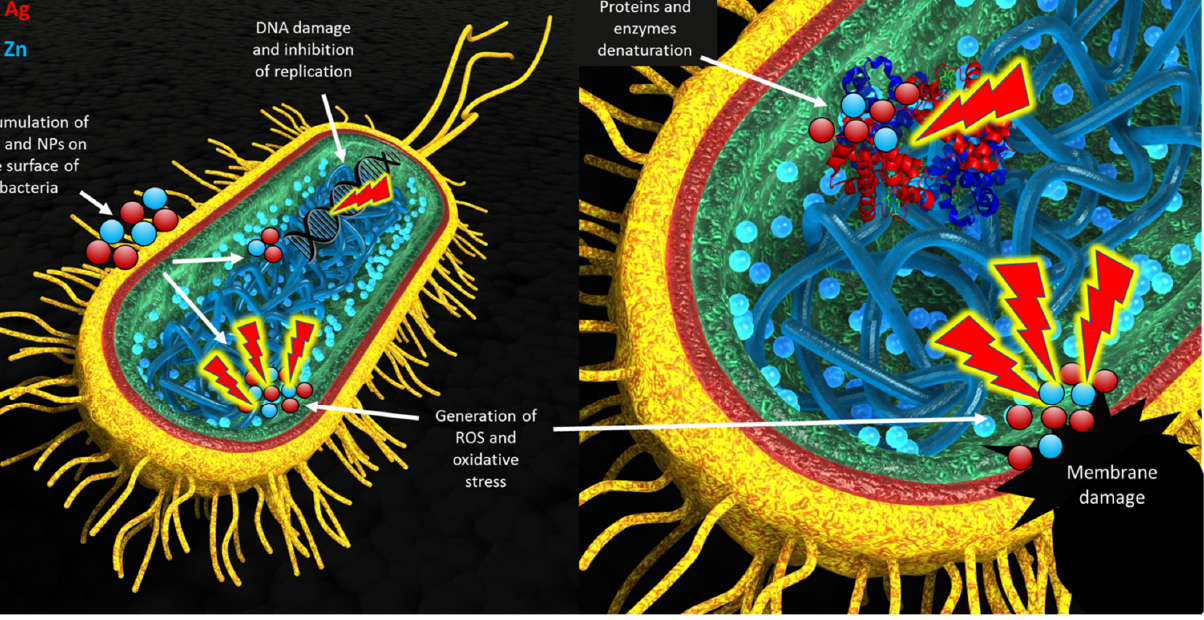
Figure 12. Scheme of possible bacterial cell interaction with nZnO:Ag particles released from the surface of the membrane. The figure was prepared by the first author using basic model of bacterial cell image, obtained with license type CC ‐ BY ‐ NC ‐ SA 4.0.